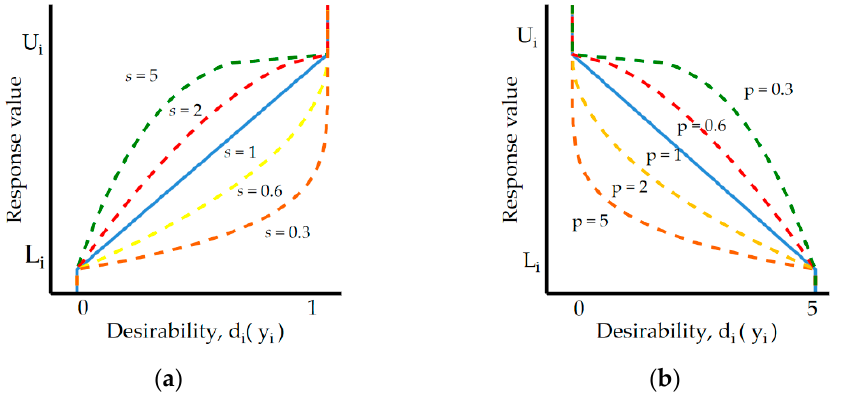
Figure 4. Derringer’s functions for criteria optimization: ( a ) maximized; ( b ) minimized.